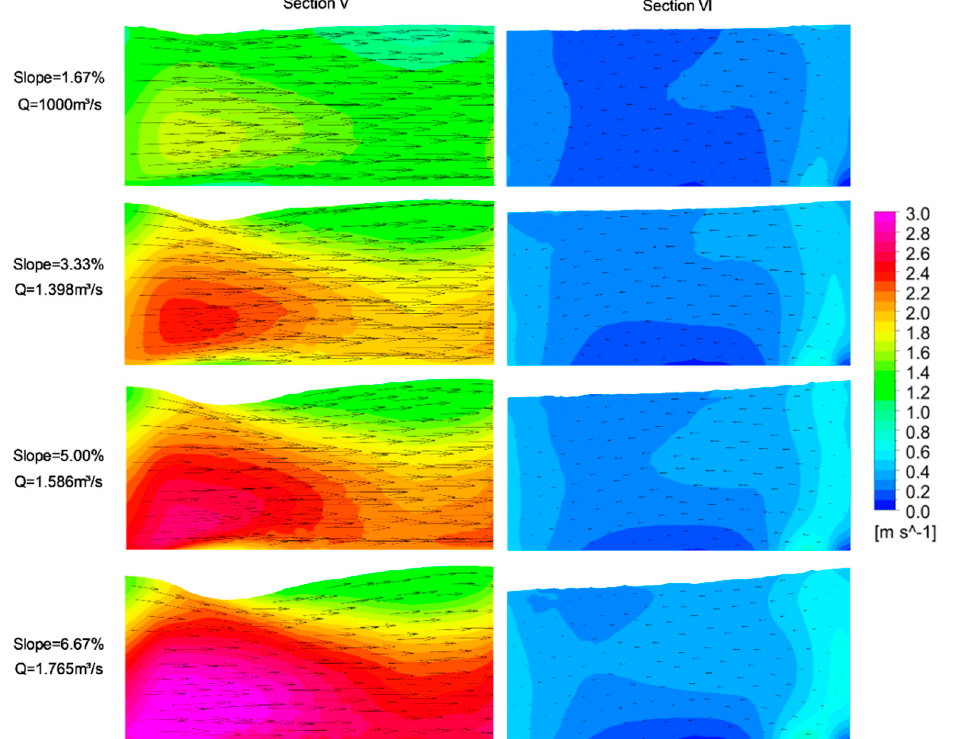
Figure 5. Velocities (V) in vertical planes parallel to the longitudinal axis of fishway sections V (y = 1.7 m) and VI (y = 0.5 m) for the four slopes tested in design D1. Details of sections in Figure